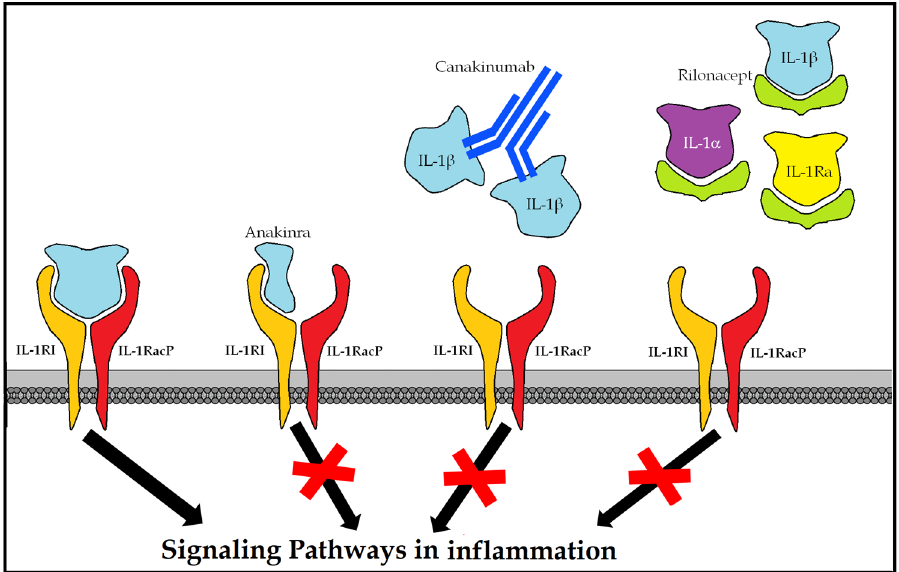
Figure 6. Therapeutic options for blocking the hyperinflammatory response mediated by